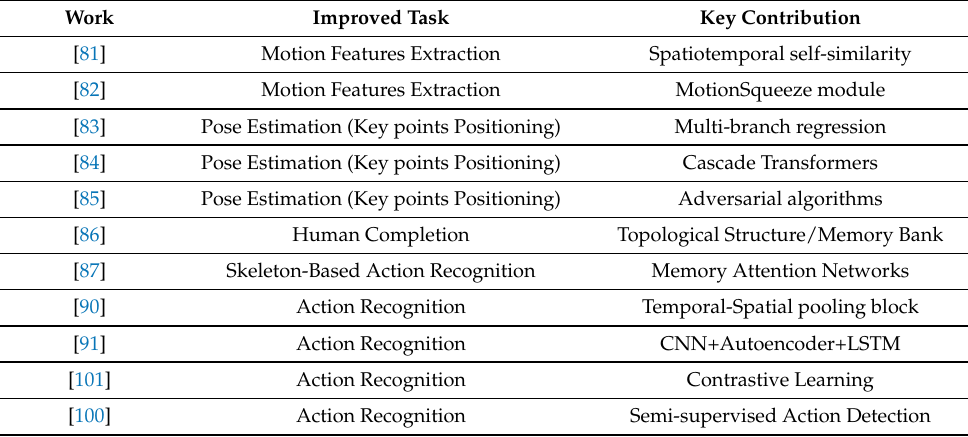
Table 5. Recent works on human motion